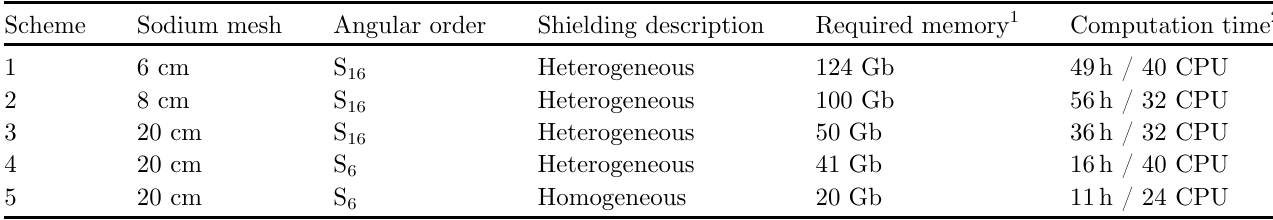
Table 5. Deterministic calculation schemes used to calculate the activation of secondary sodium in the neutron